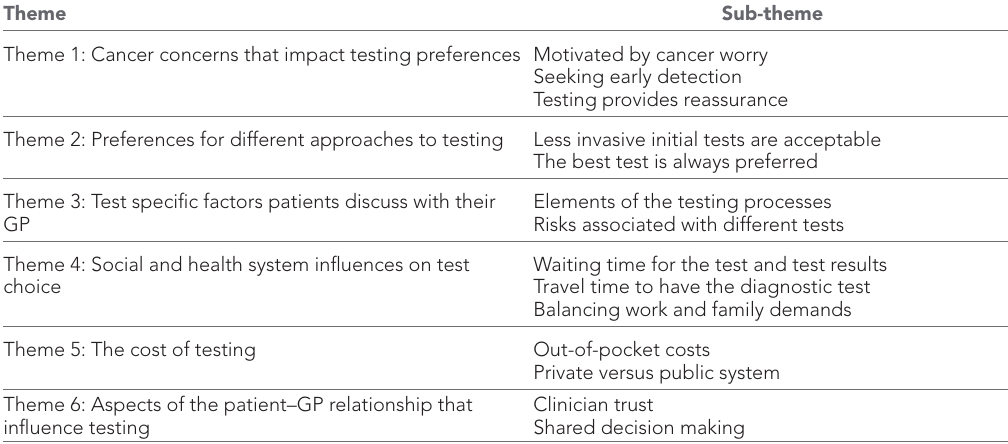
Table 2 Themes and sub- themes derived from interviews with 15 Australian GP patients Theme Sub- theme Theme 1: Cancer concerns that impact testing preferences Motivated by cancer worry Seeking early detection Testing provides